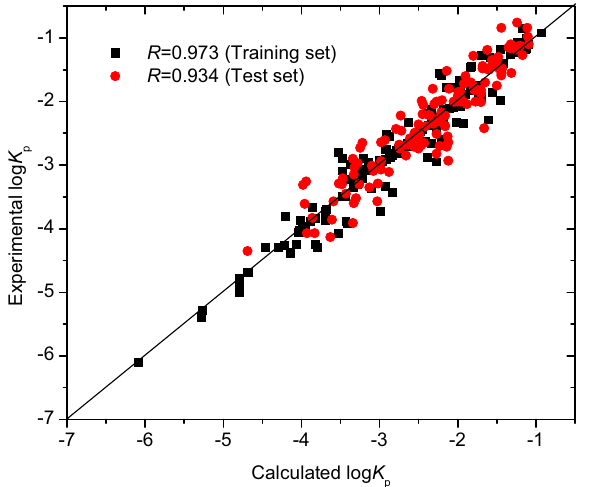
Figure 5. Plot of experimental versus predicted log K p with SVM model, generated by OriginPro 7.5